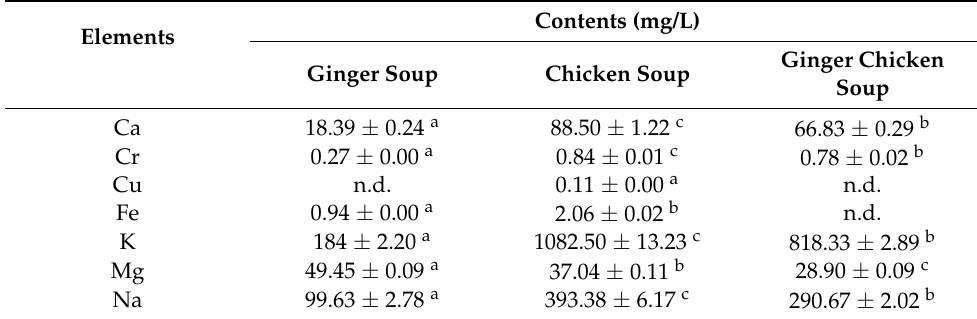
Table 3. Mineral contents of different